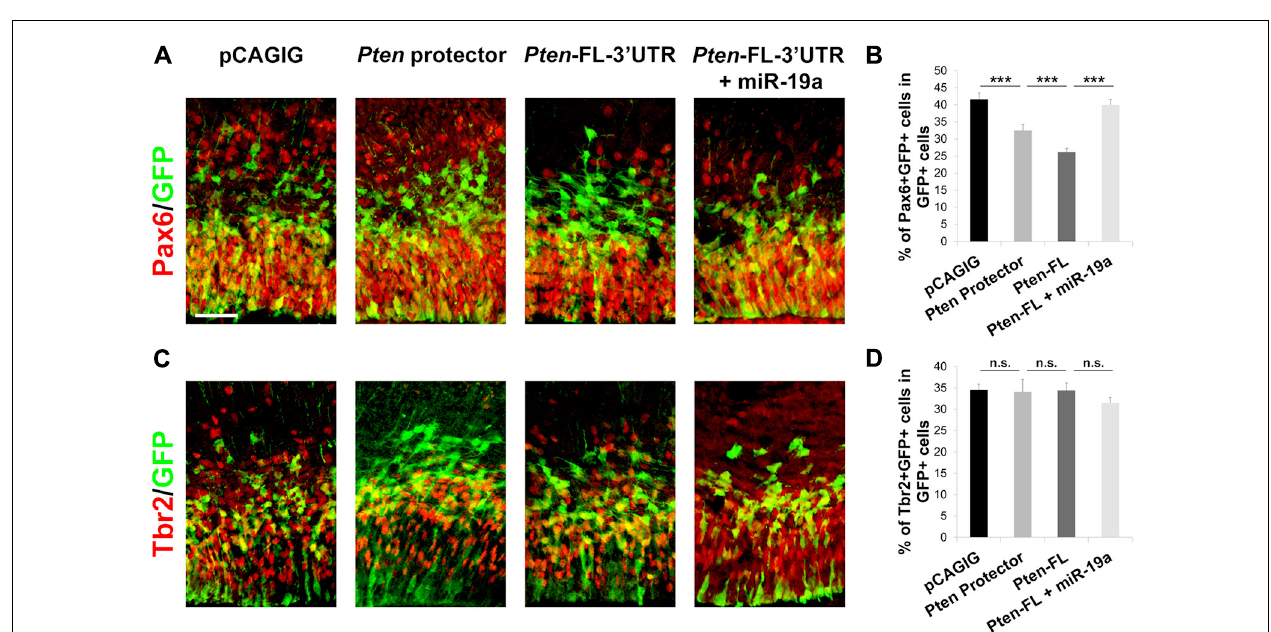
FIGURE 4 |Target protectors block miR-19a repression of Pten in the developing mouse cortex. (A–D) Electroporation of the 60 nt target protector at E13.5 for analysis at E14.5 significantly decreased the number of BrdU-incorporating or Ki67 + proliferative cells colabeled with GFP in the cortex. Ectopic expression of full length